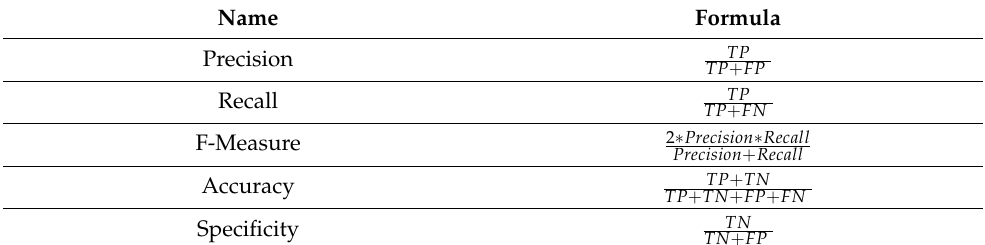
Table 4. Indices